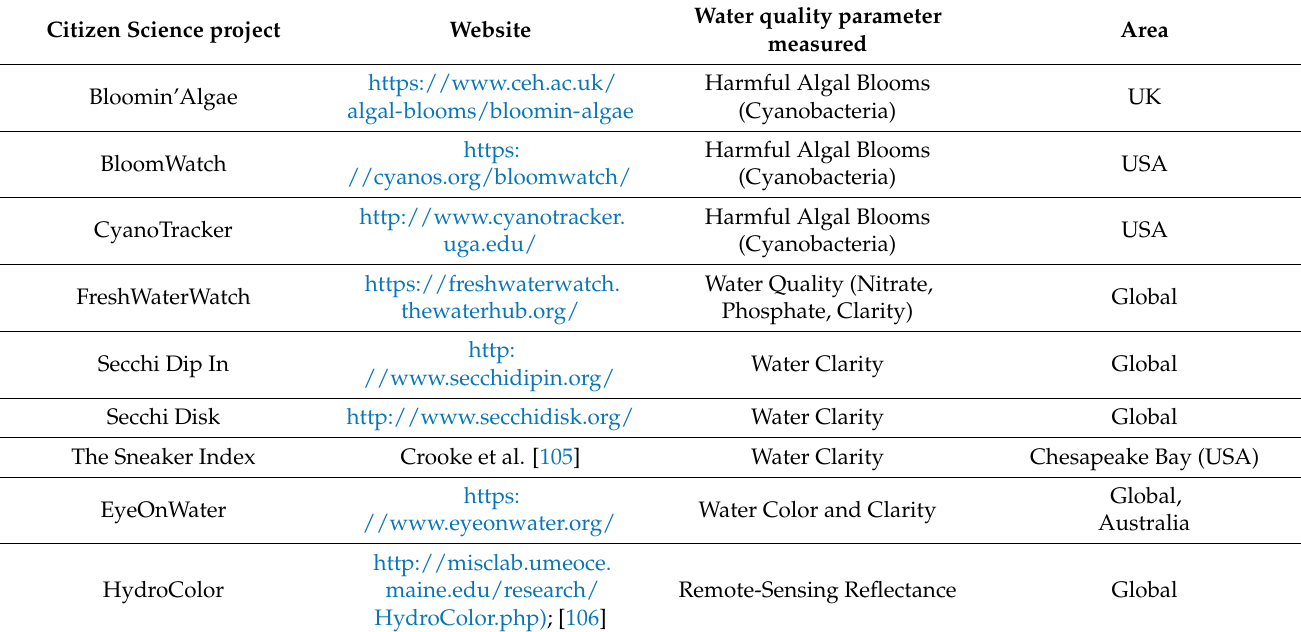
Table 1. Examples of citizen science projects focused on water